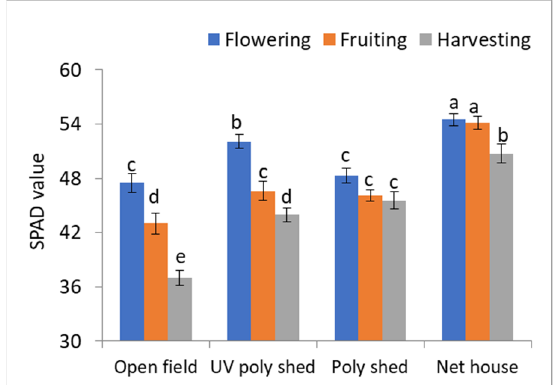
Figure 2. Average leaf chlorophyll content (SPAD reading) of papaya grown under different sheds and open field condition. Mean ± Standard error (S.E.) (n = 15). Means with the same lower case letter are not significantly different at p = 0.05 by Duncan’s multiple range test.